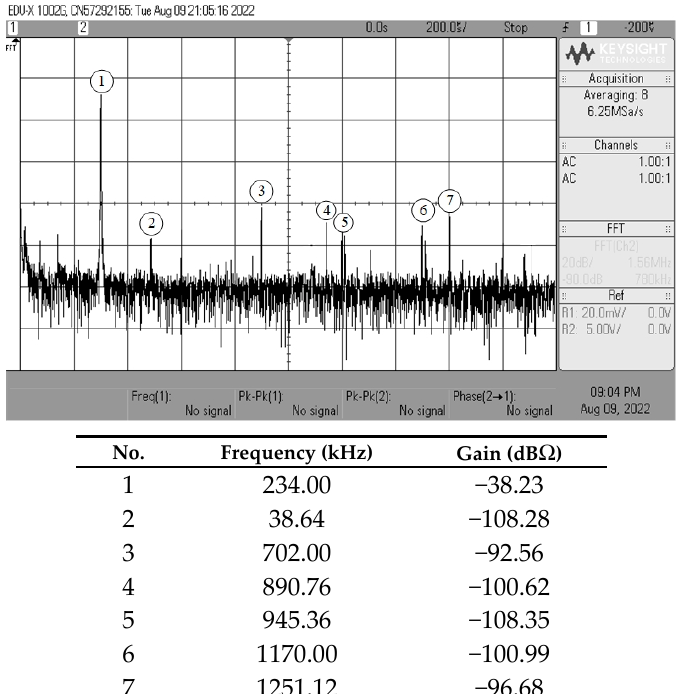
Figure 20. Experimentally observed frequency spectrum of v o(TIM) of the AP filter in TIM.